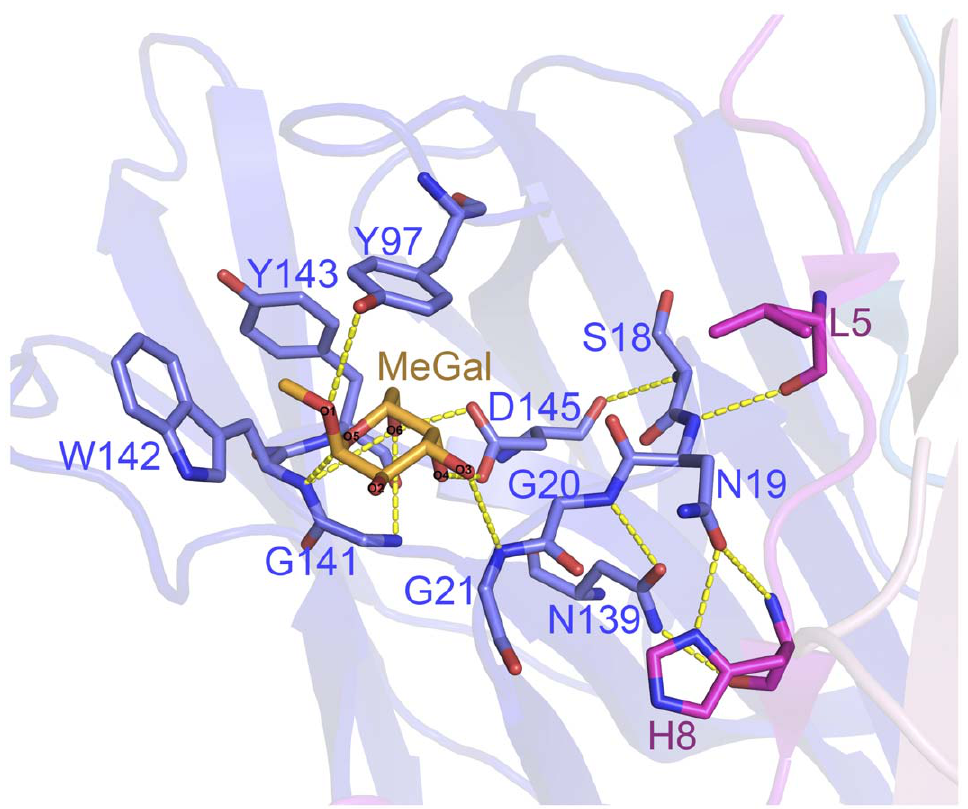
Figure 8. Hydrogen bond networks between carbohydrate binding pocket of chain A and N terminus of chain B. The carbohydrate binding pocket of chain A is shown in blue, and the N terminus of chain B is shown in magenta. The monosaccharide Me-Gal is orange. Four hydrogen bonds are formed: 2 by the atom OD1 of Asn19 (chain A) and the atoms ND1 and N of His 8 (chain B); 1 by the atom N of Asn19 (chain A) and the atom O of Leu5 (chain B); and 1 by the atom ND2 of Asn139 (chain A) and the atom O of His8 (chain B).